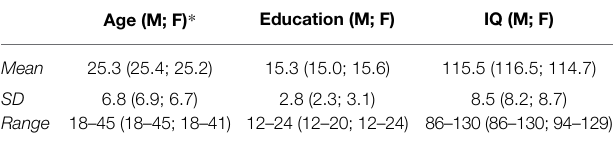
TABLE 1 | Demographic characteristics of the sample ( N = 101).